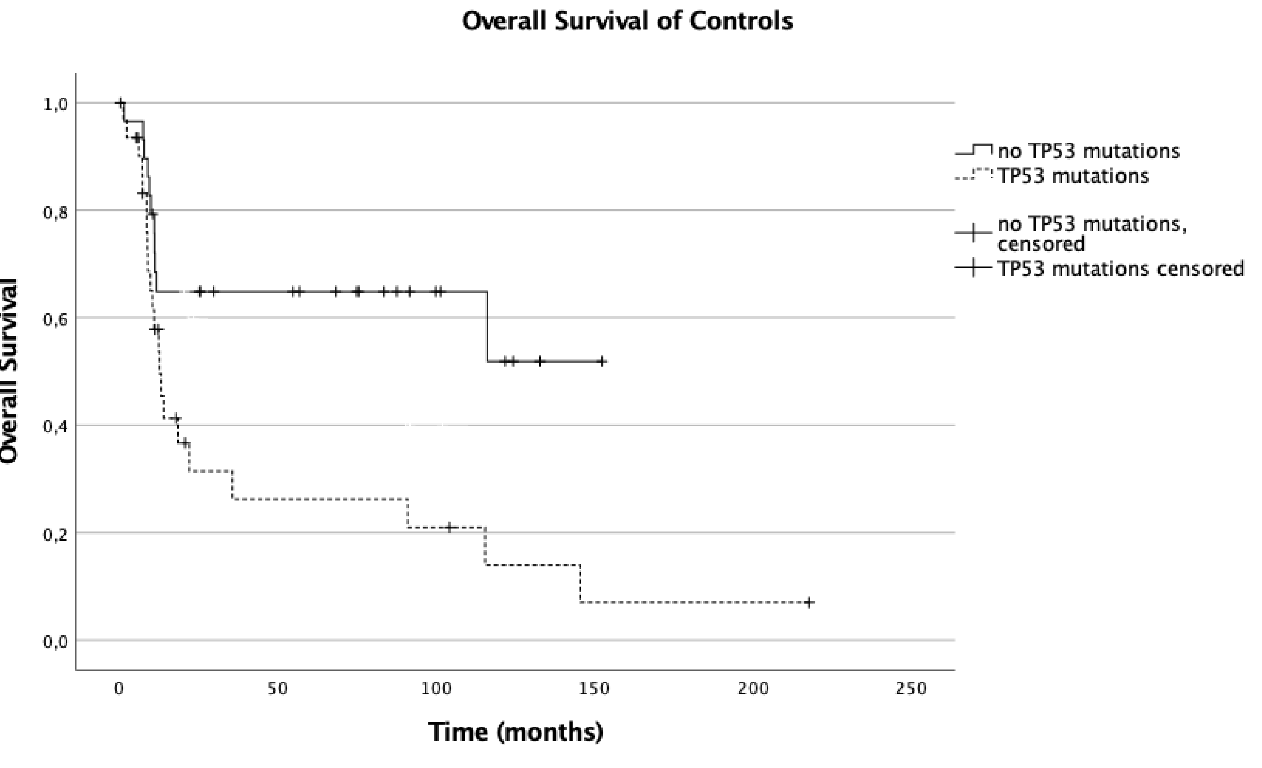
Figure 1. Overall survival of controls.